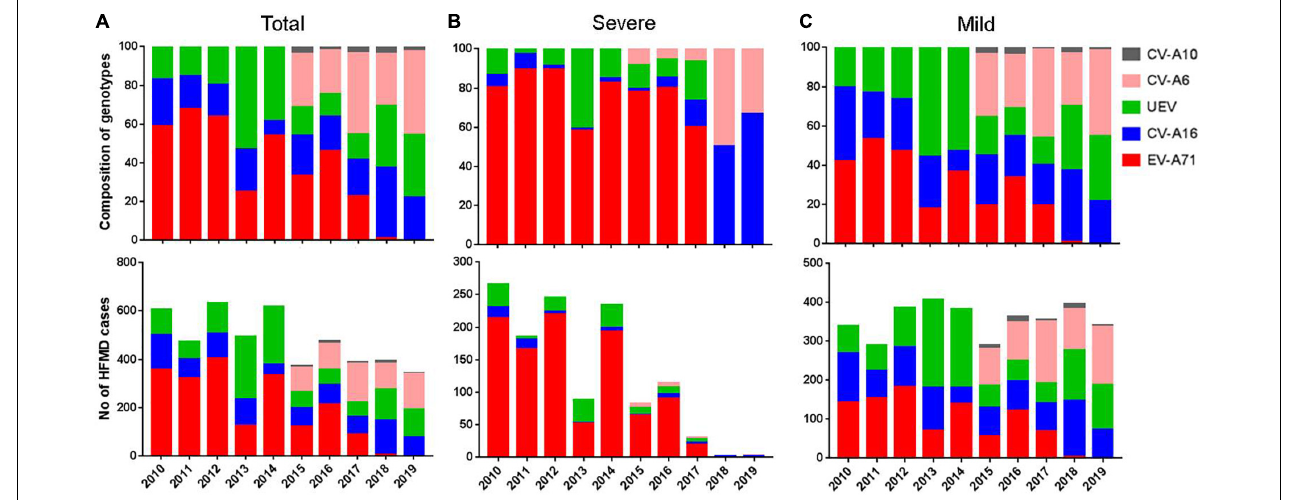
FIGURE 4 | Enterovirus distribution of different serotypes in Nanchang, China from 2010–2019. (A) Number and composition of different serotypes in all laboratory confirmed cases. (B) Number and composition of different serotypes in mild cases. (C) Number and composition of different serotypes in severe cases. After 2015, typing of CV-A6 and CV-A10 was